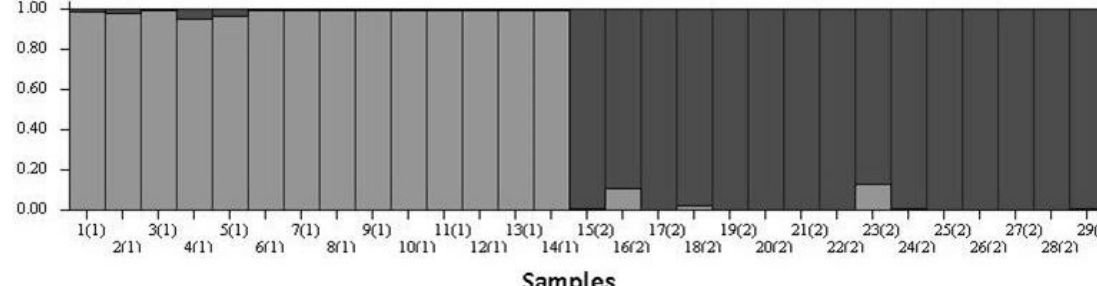
Fig 5 . Population of M. quadrifasciata from the mouth of the river São Francisco (light grey) and from the semiarid region (dark grey) showing the formation of two distinct clusters using Baysian